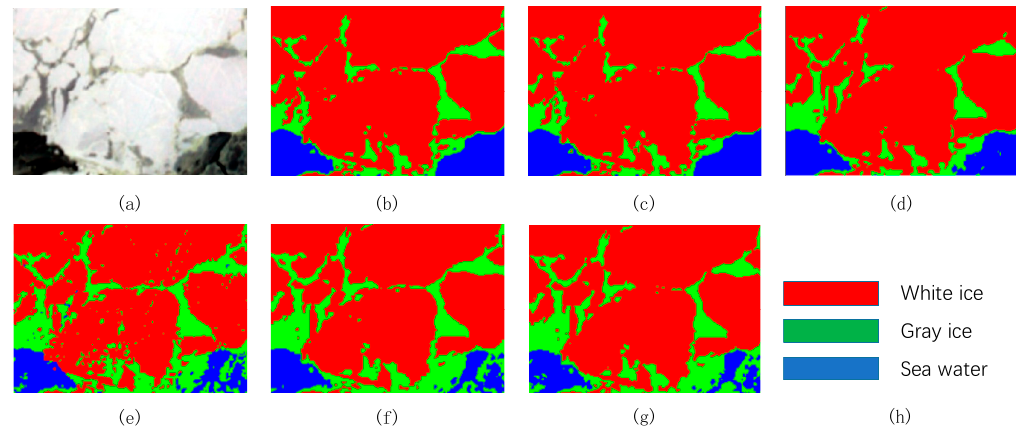
Figure 6. Classification maps of the Baffin Bay data set: ( a ) False-color composite; ( b ) SVM; ( c ) 1D-CNN; ( d ) 2D-CNN; ( e ) 3D-CNN; ( f ) GLCM-CNN; ( g ) Proposed; ( h ) class legend of the Baffin Bay image.